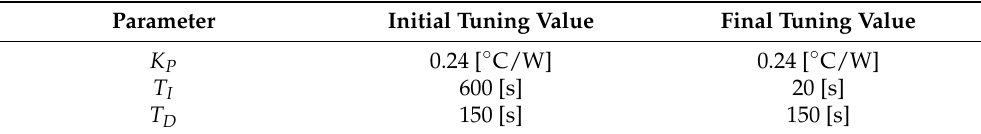
Figure 19. Control results: Smith predictor architecture tuning. Table 12. Smith predictor architecture tuning.